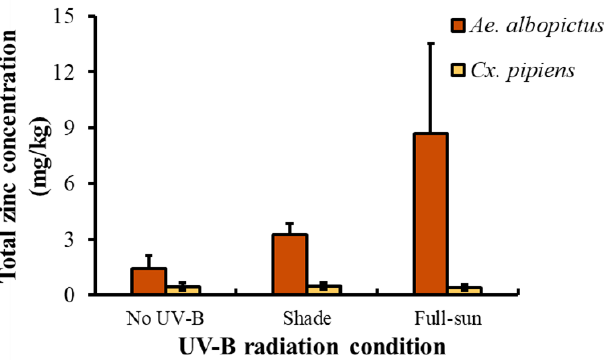
Figure 4. Least square means (± SE) total zinc concentration in mosquitoes (mg/kg) for Ae. albopictus and Cx. pipiens in response to UV-B radiation treatment. Data were statistically tested using ANOVA. No letters indicate no significant pairwise differences ( p > 0.05).